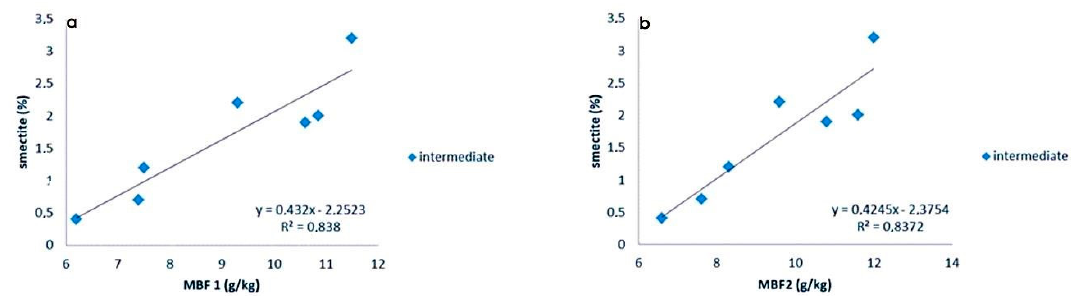
Figure 8. ( a ) Methylene blue test (MB F 1) plotted against the smectite content of the intermediate studied rocks, ( b ) modified methylene blue test (MB F 2) plotted against the smectite content of the intermediate studied rocks.